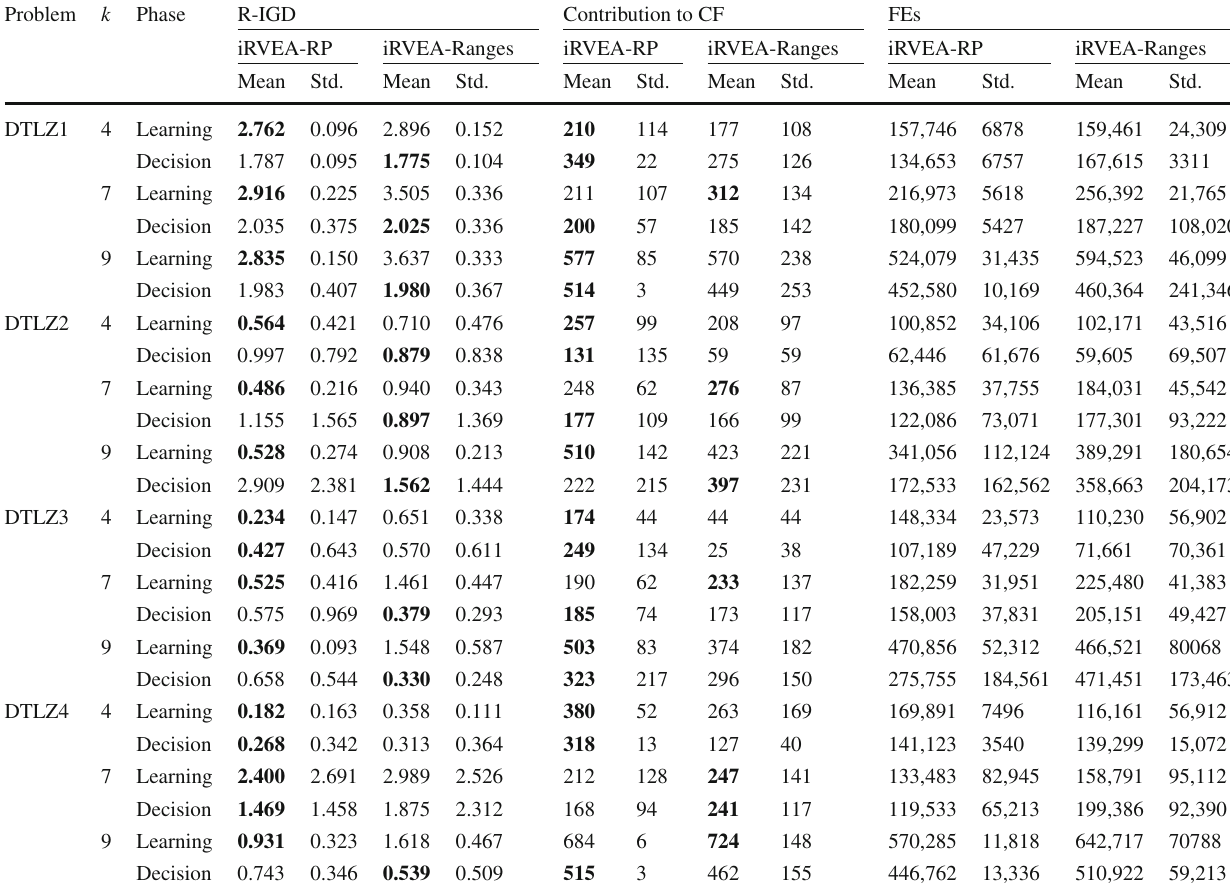
Table 2 Cumulative results of the comparison of reference point- and preferred range-based iRVEA Problem